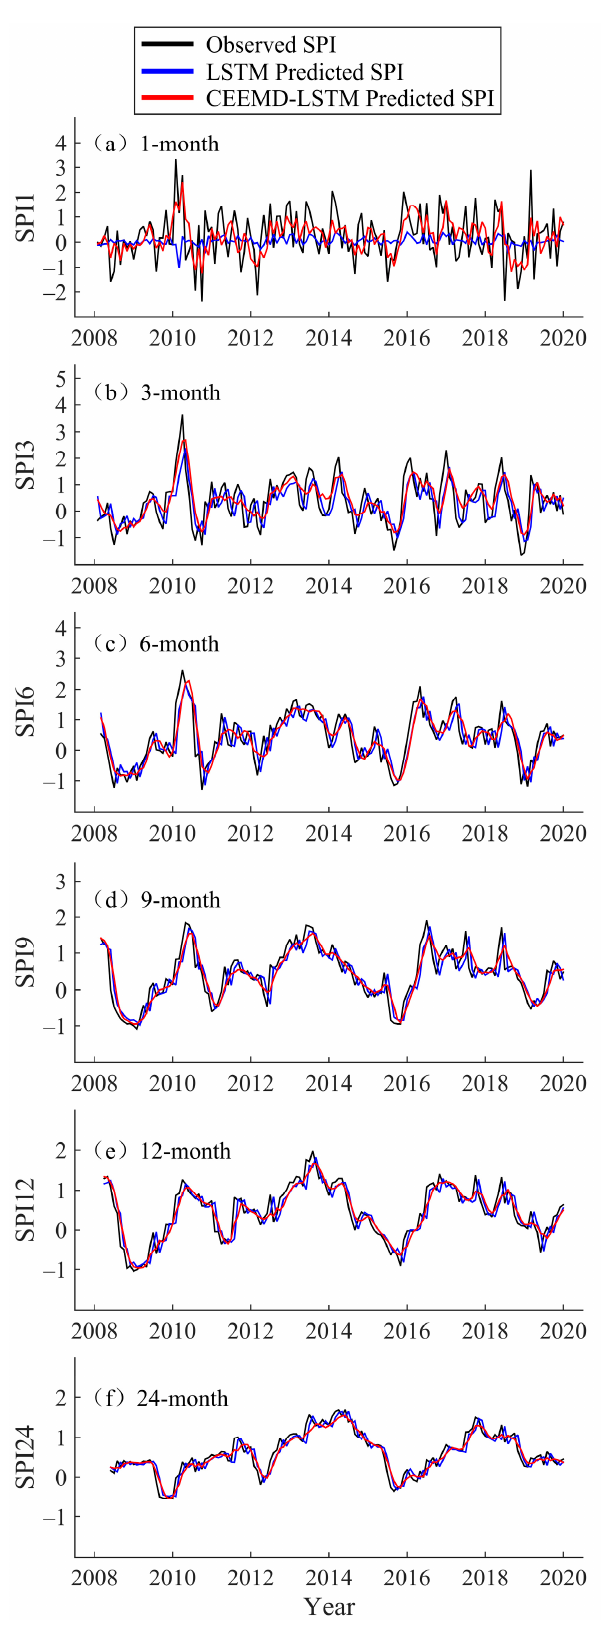
Figure 5. Forecast of multi-timescale SPI values of the LSTM and CEEMD-LSTM model at Fuhai Station (2008–2019).